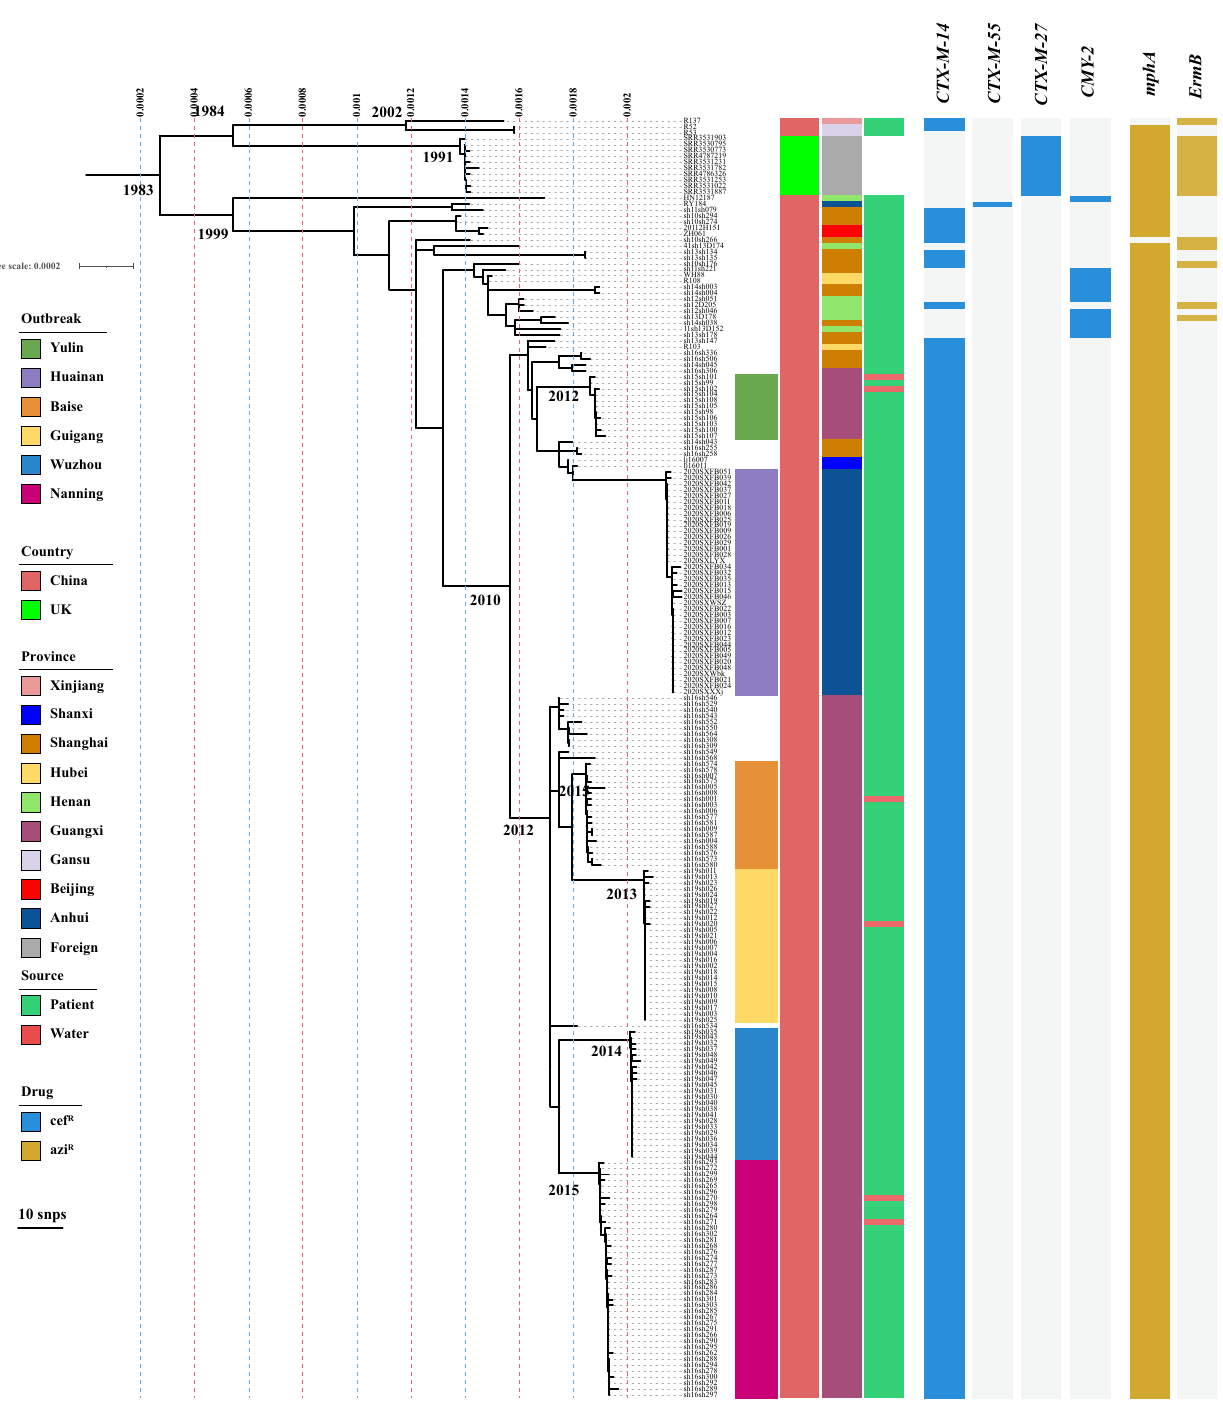
shown with a heatmap. Source data are provided as a Source Data fi le. cef R resis- tance to ceftriaxone, azi R resistance to azithromycin, SNP single-nucleotide poly- morphism, cef R azi R coresistance to ceftriaxone and azithromycin, AMR antimicrobial